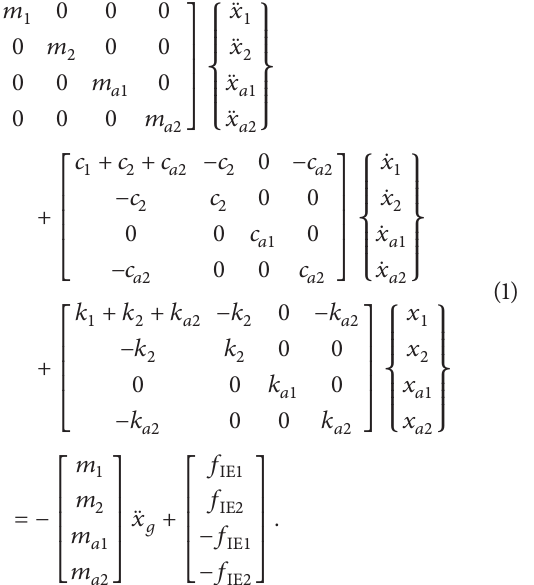
of the interface elements of the 1st and 2nd substructures are listed as